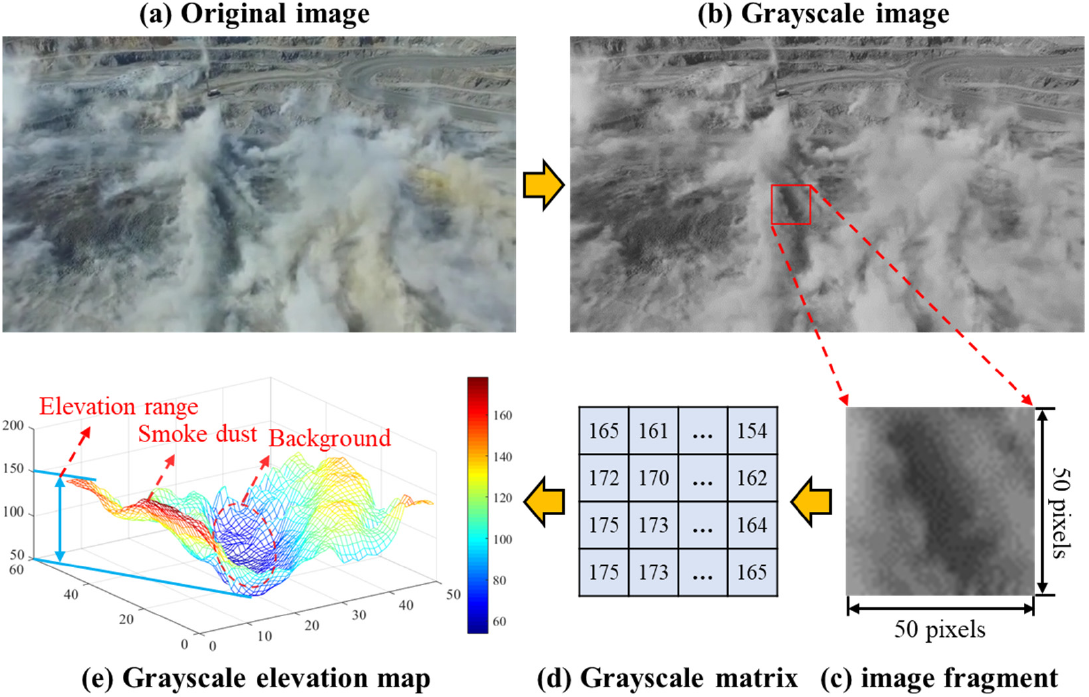
Figure 5. Grayscale elevation map of smoke dust with homologous calculation processes, including ( a ) original image of smoke dust, ( b ) gray image, ( c ) image fragment of gray image, ( d ) digital matrix of the image fragment, and ( e ) grayscale elevation map based on the image fragment.